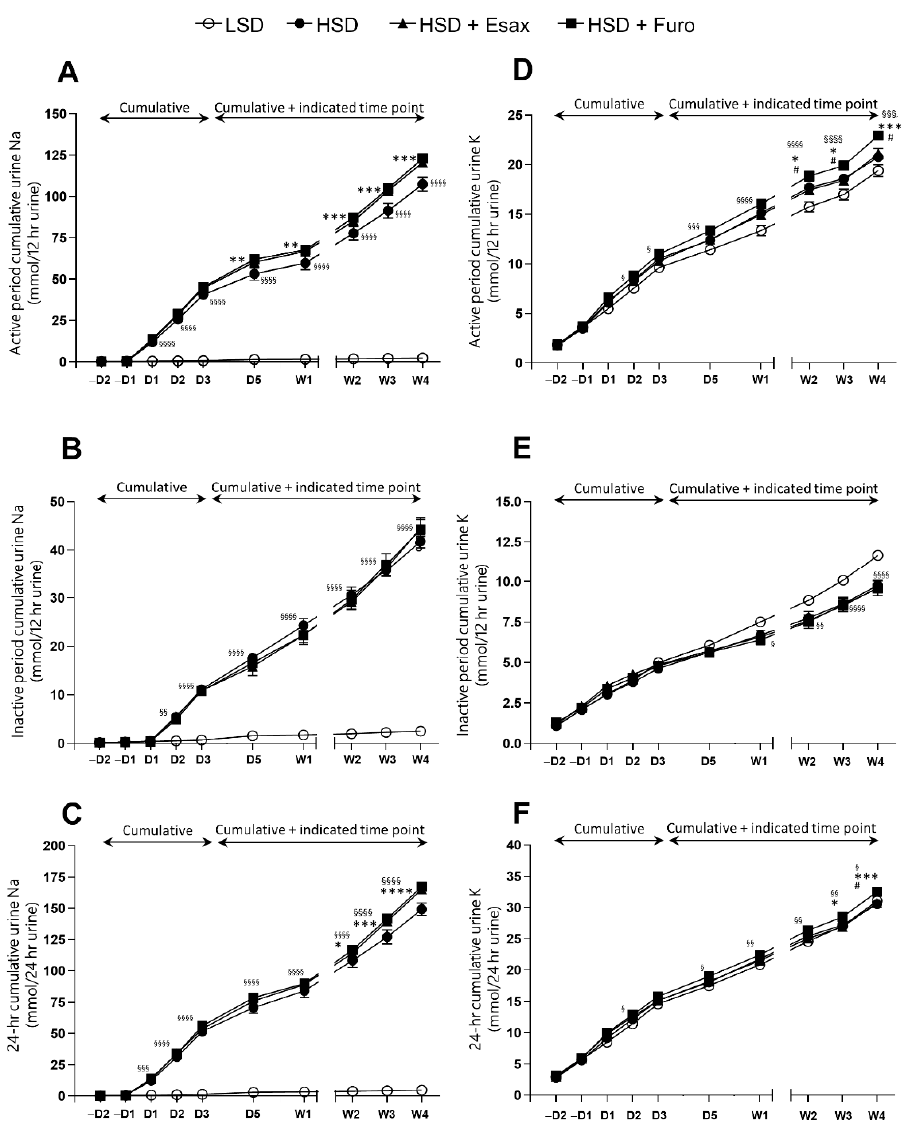
Figure 2. Urinary excretion of Na and K. Cumulative 12 h urinary excretion of Na in the ( A ) active and ( B ) inactive periods and ( C ) at 24 h. Urinary excretion of K in the ( D ) active and ( E ) inactive periods, and ( F ) at 24 h. § p < 0.05, §§ p < 0.01, §§§ p < 0.001 §§§§ p < 0.0001 vs. LSD; * p < 0.05, ** p < 0.01, *** p < 0.001, **** p < 0.0001 vs. HSD; # p < 0.05 vs. HSD plus